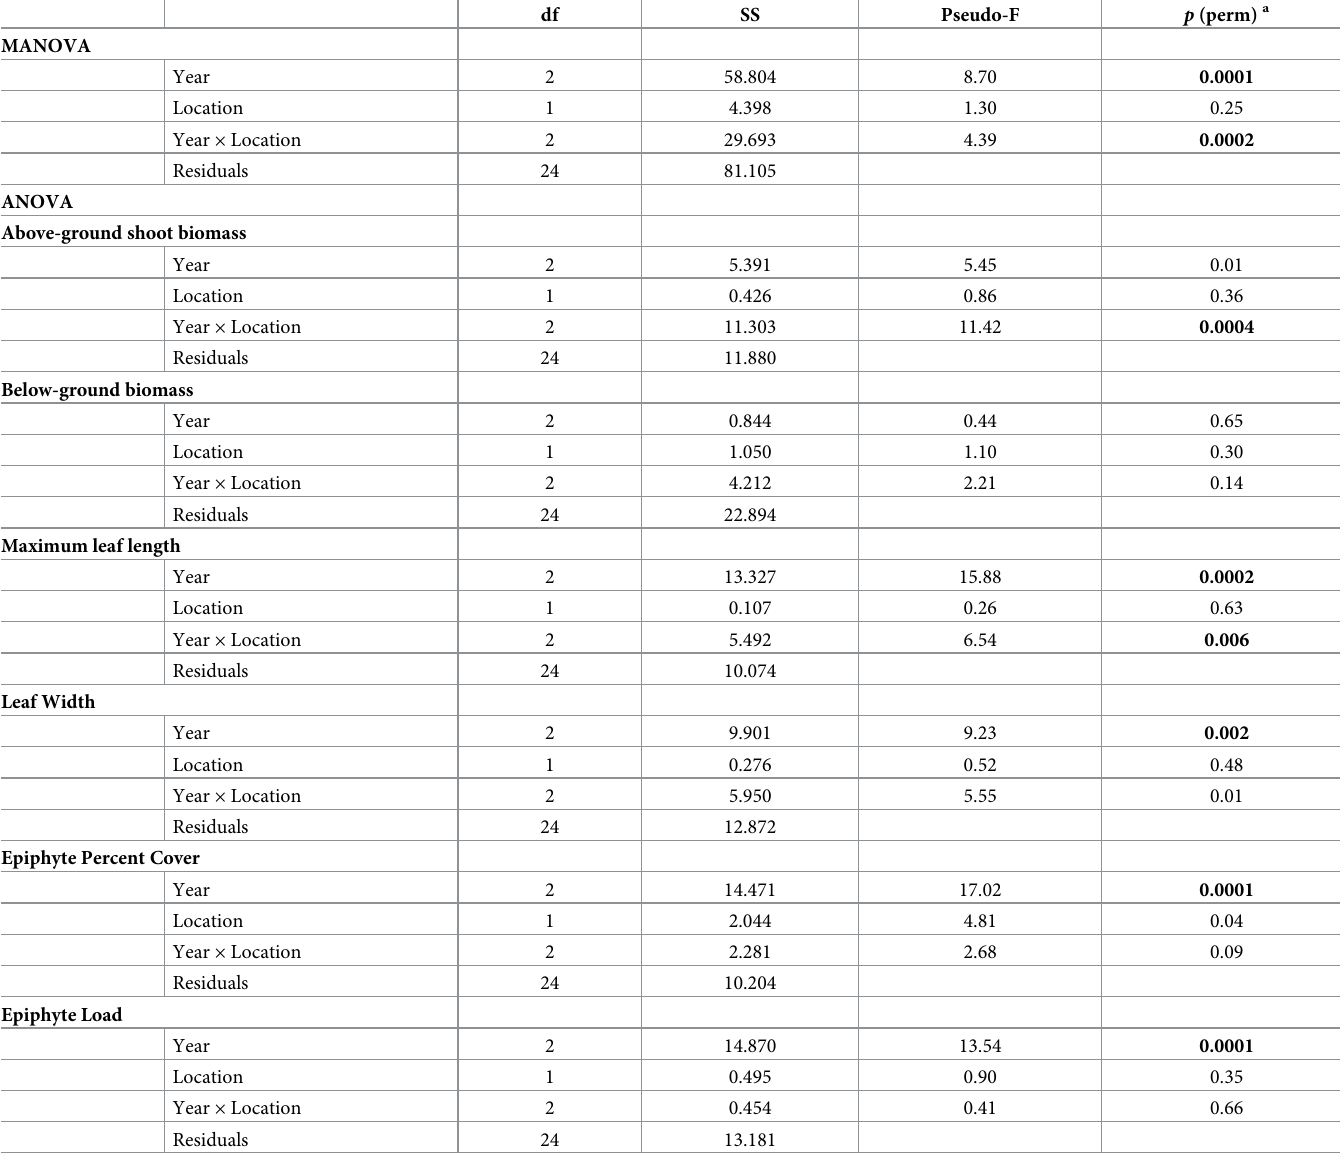
Table 2. Permutational ANOVA results examining the effect of oyster restoration on eelgrass response variables combined (MANOVA) and then individually (ANOVA). df SS